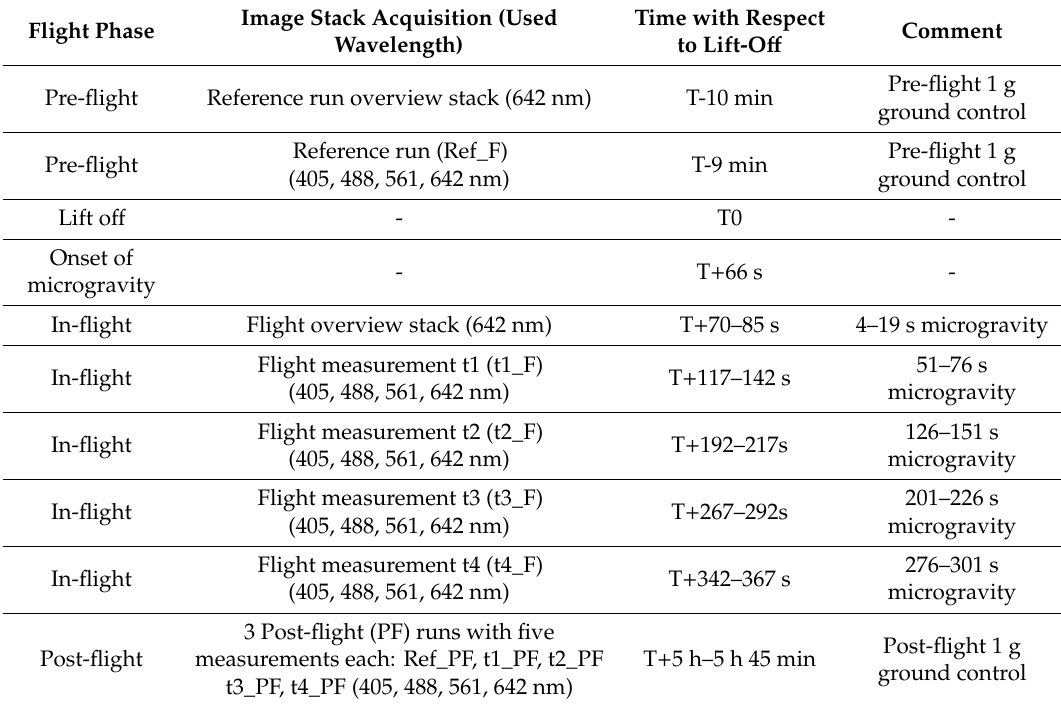
Table 3. Microscopic image stack acquisition during the FLUMIAS TEXUS-54 experiment. Microgravity exposure times are calculated from the start of the microgravity phase until the end of the respective measurement.